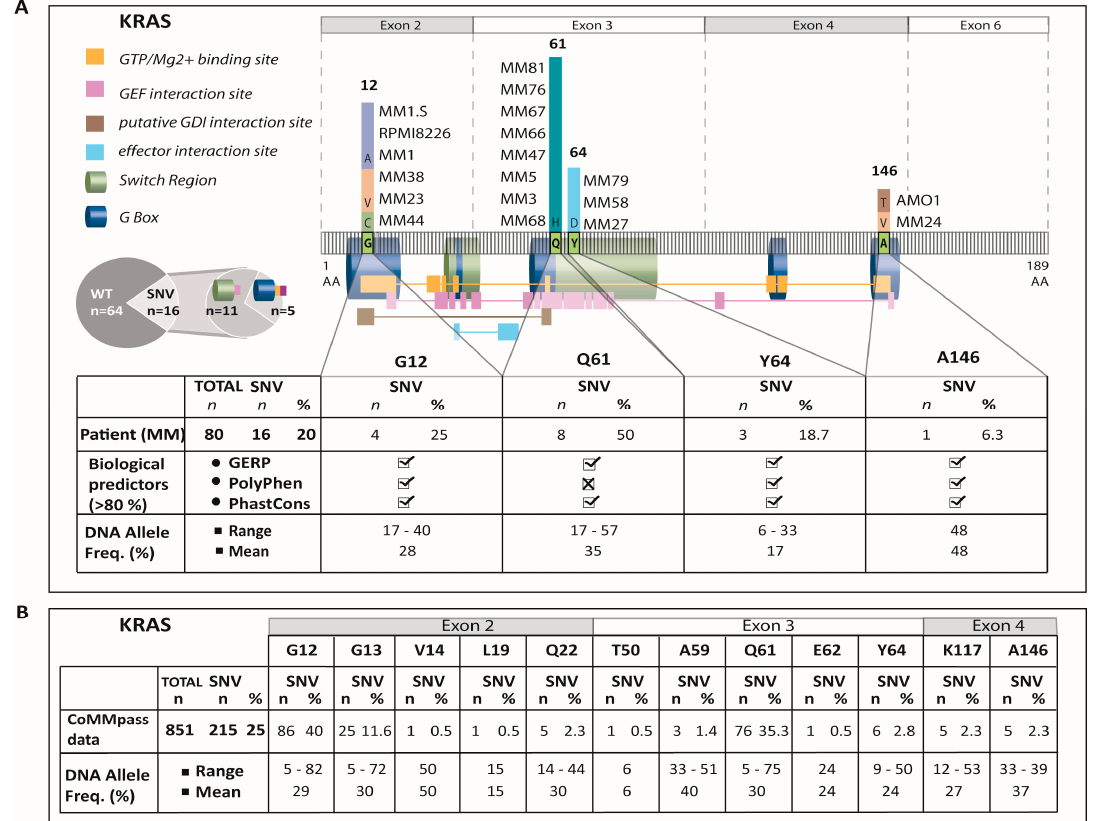
Figure 1. Distribution of KRAS mutations in the MM cohort studied, and also including two MM cell lines (AMO1, MM1.S) with known KRAS -mutations [26], ( A ) and within the CoMMpass dataset which